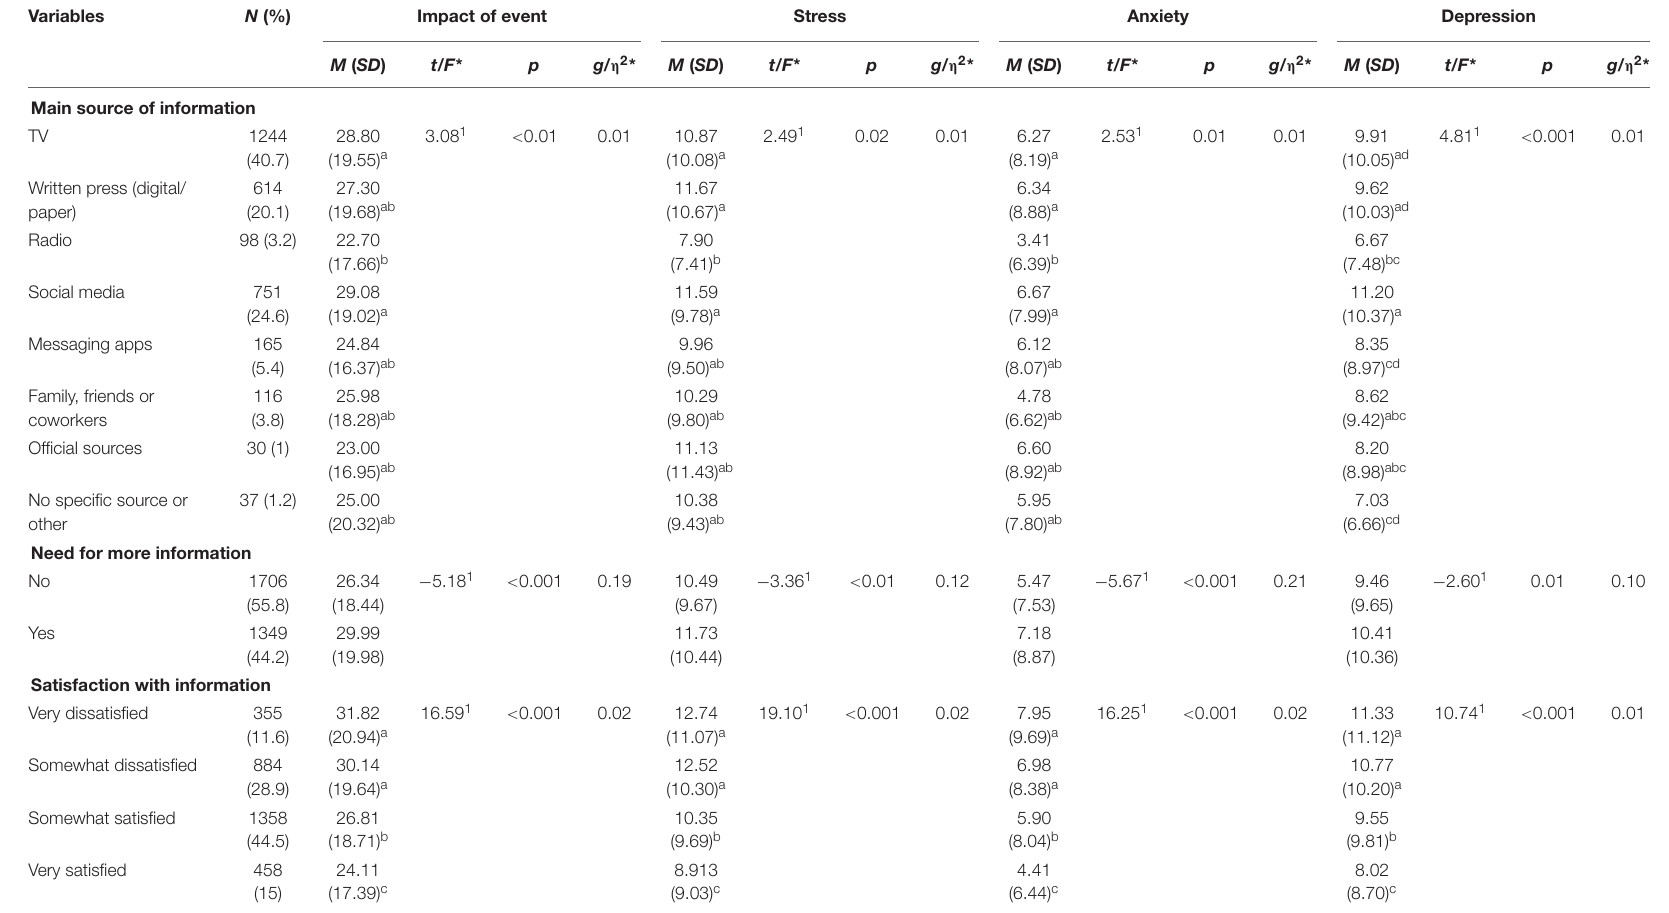
TABLE 8 | Association between variables related to information about the COVID-19 pandemic and the psychological impact of the COVID-19 pandemic as well as mental health status during the pandemic ( N = 3055). Variables N (%) Impact of event Stress Anxiety